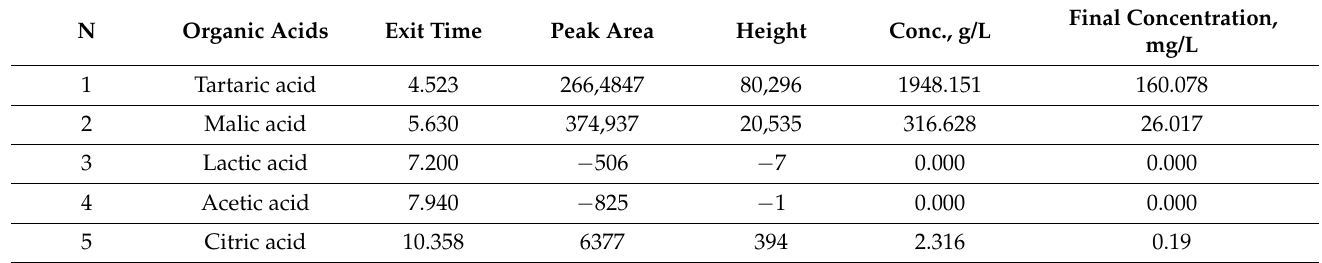
Table 4. Analysis of organic acids in culture liquid L. ferriphilum CC by HPLC.